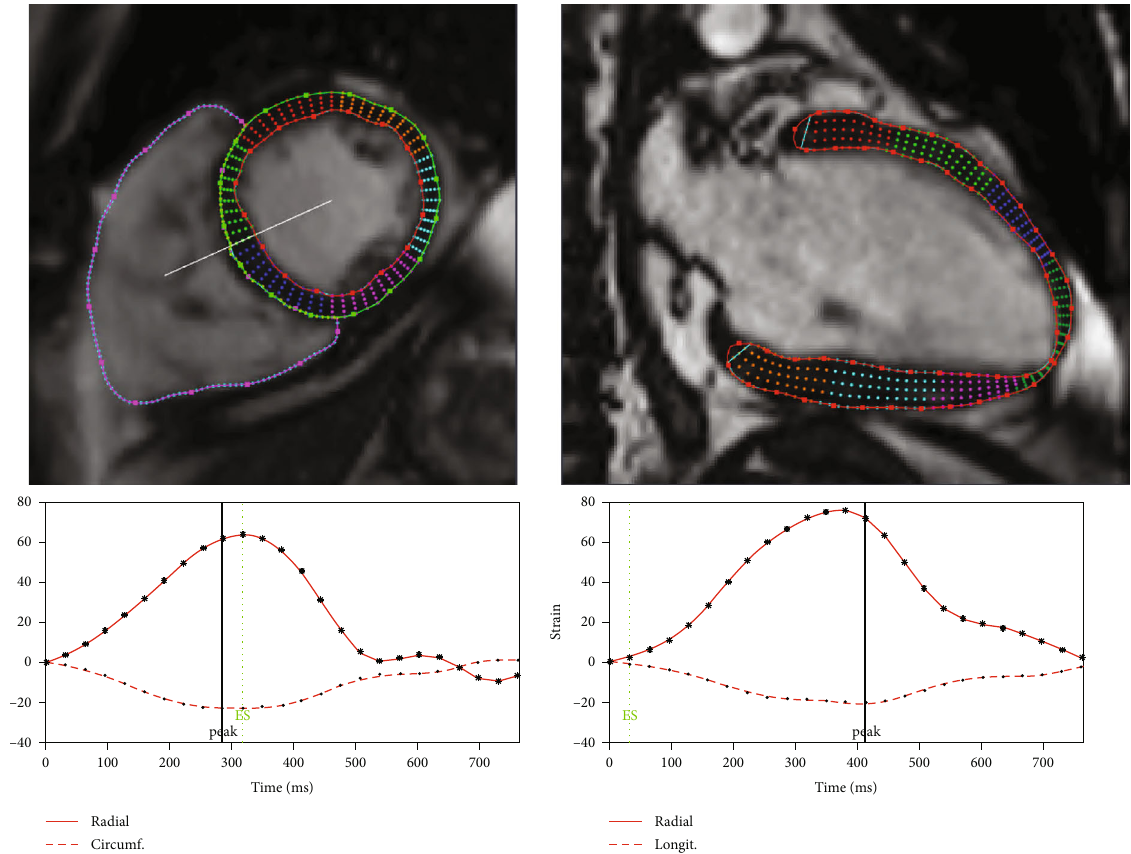
Figure 2: Detected myocardium on cine images using Segment CMR: short-axis and long-axis views. Strain curves are bellow corresponding